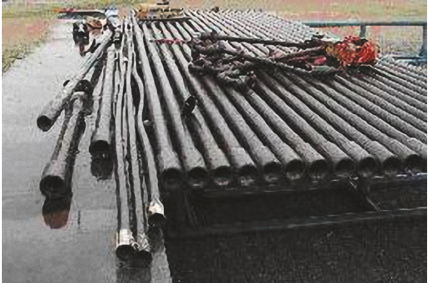
Figure 2: Tube buckling caused by perforation load.